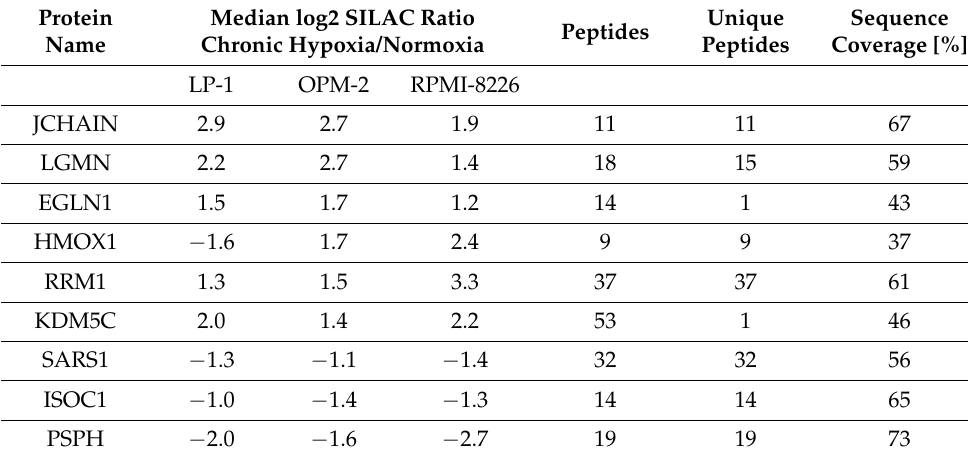
Table 3. Significant hypoxia-regulated proteins in Multiple Myeloma cell lines LP-1, OPM-2 and